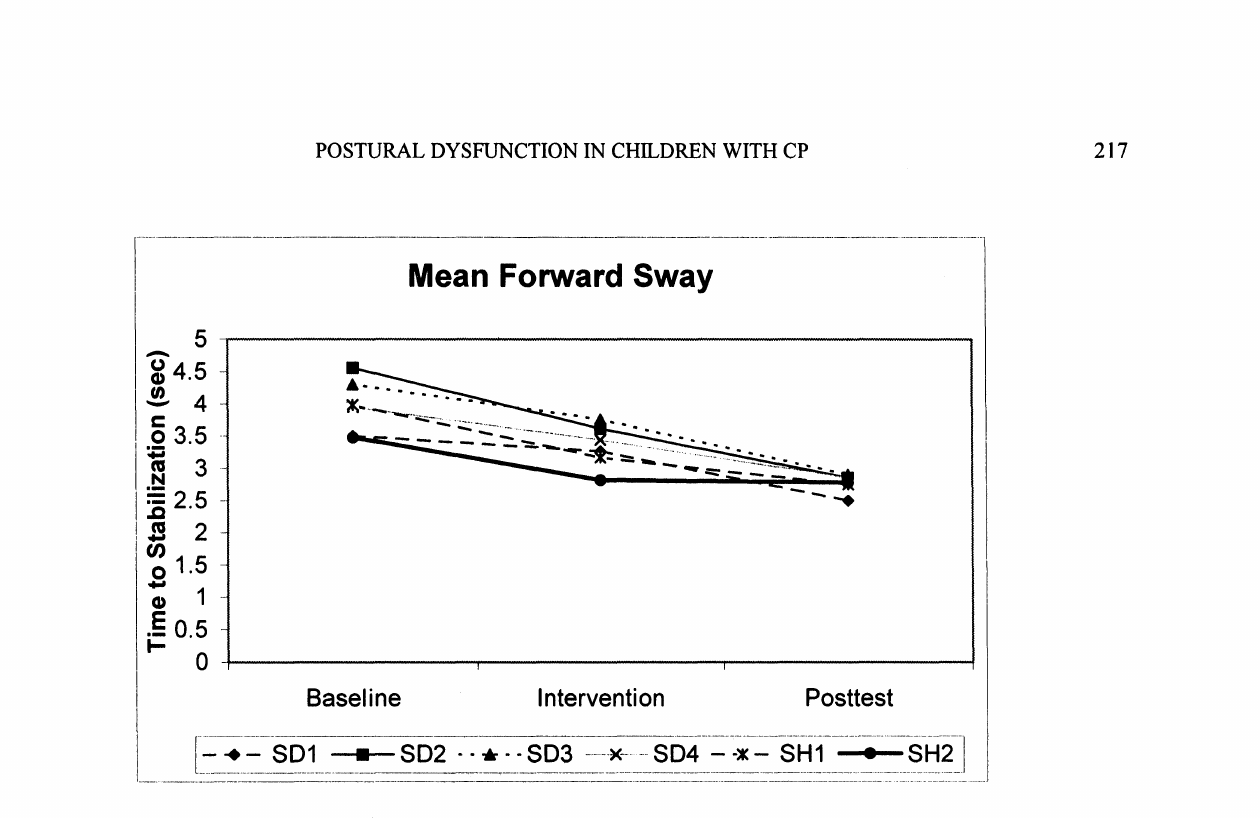
Fig. 3: COP time to stabilization (TTS) of balance after a forward sway perturbation in the six children, during baseline, intervention and maintenance (post-test) phases (Abbreviations: SD 1-4